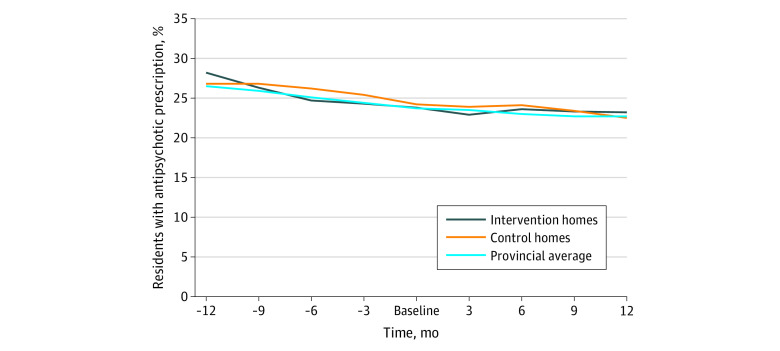
Proportion of Residents Receiving Any Antipsychotic Prescription 1 Year Before and After Intervention